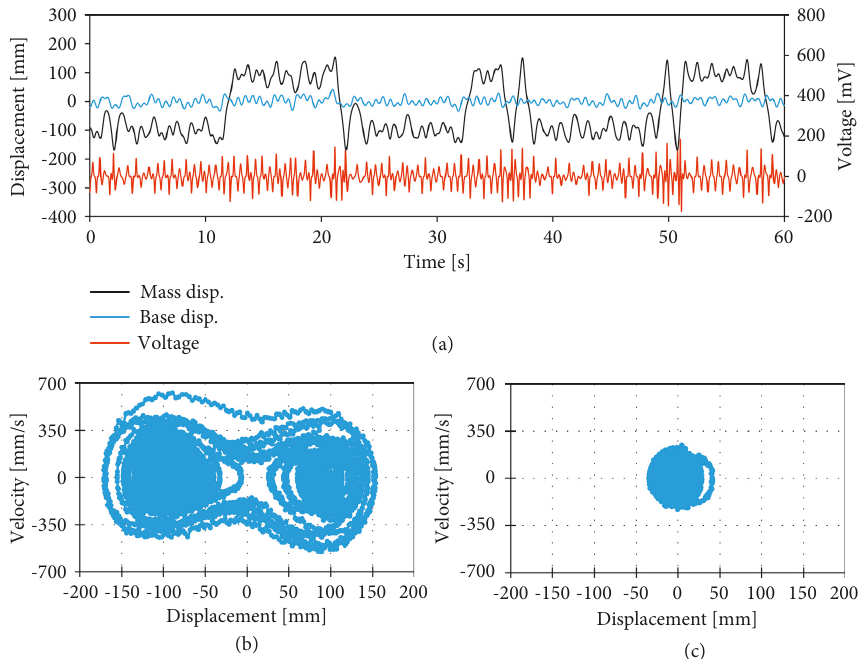
Figure 12: Measured results for vibration displacement and vibration power generation for vibration with a random signal and a periodic signal at 1.50 Hz. (a) Response vibration displacement results. (b) Diagram of displacement vs. velocity of vibration for the mass block. (c) Diagram of displacement vs. velocity of vibration for the